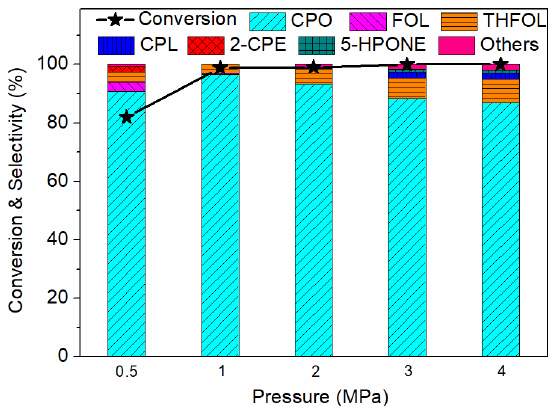
Figure 9. Effect of hydrogen pressure on conversion and product selectivity in hydrogenative ring- rearrangement of FAL over Pd/UiO-66-NO 2 - 7 . Reaction conditions: catalyst (5.0 mg), FAL (100.0 mg), H 2 O (9.9 g), 150 °C, 5 h.